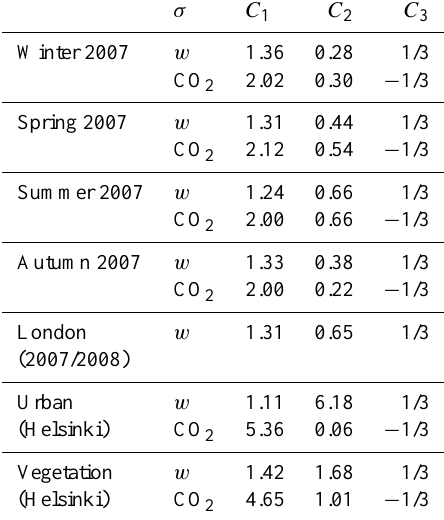
Table 3. Coefficients for normalised standard deviation of vertical wind velocity and CO 2 concentration (Eqs. 2 and 3) by seasons (2007, this study), 2007/2008 (Wood et al., 2010a) and for two land- use classes (urban and vegetation) observed in a study in Helsinki, Finland (Vesala et al.,